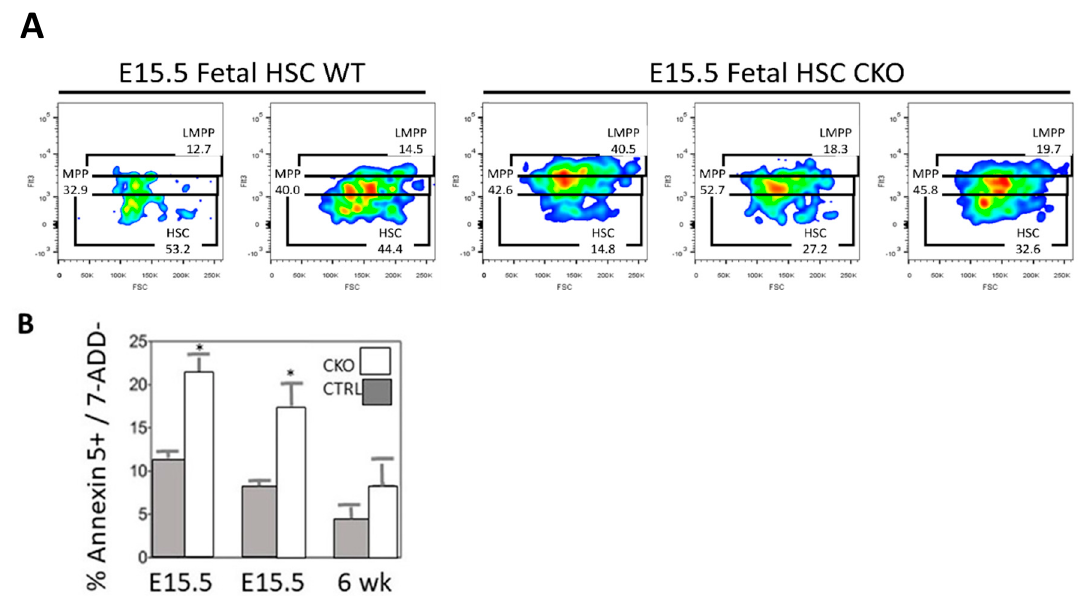
Figure 2. SMYD2 is required for expression of fetal liver (FL) definitive Hematopoietic Stem Cells (HSCs). ( A ) FACS analysis of E15.5 FL Lin - Sca1 + ckit + Flt3 - HSC reveals significant reductions in vav -Cre / Smyd2 F / F (CKO) relative to vav -Cre / Smyd2 F / WT (WT). Data shown are the average of five independent experiments analyzed by Student’s Test ( B ). FACS sorted cell populations from embryonic (E) day 15.5, and 6-week aged mice were incubated with Annexin V for 15 min at room temperature followed by addition of 7-AAD, and then immediately analyzed by flow cytometry. Shown are the averages of 3–5 independent experiments. * p ≤ 0.05.